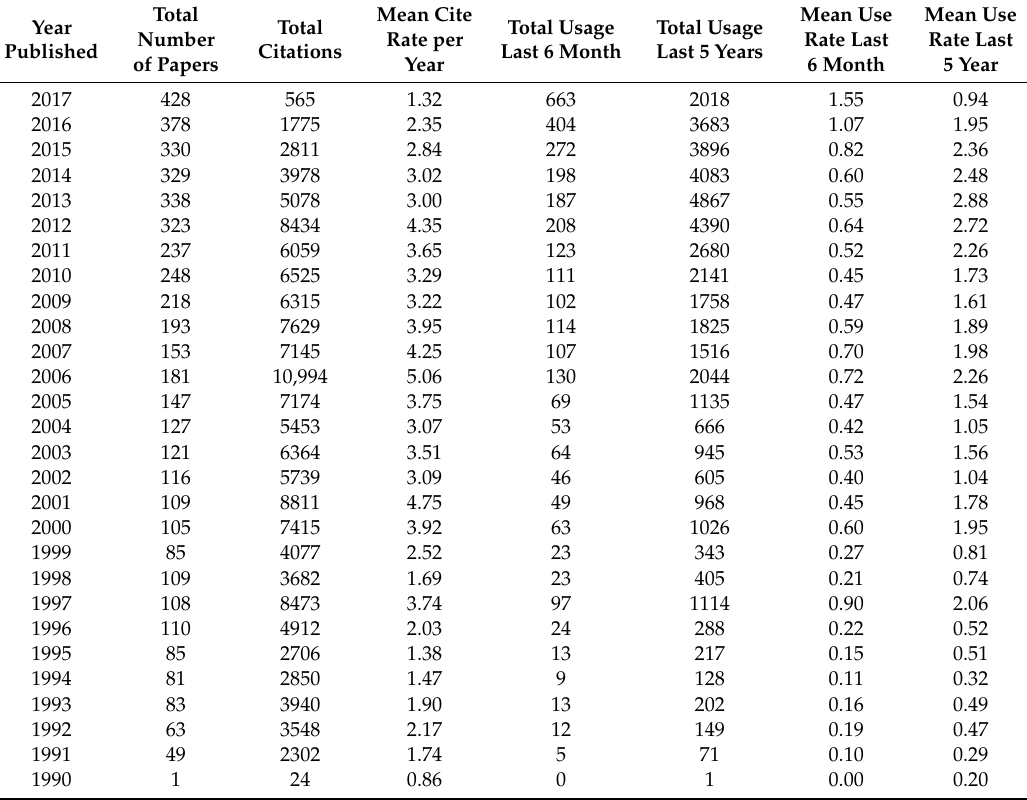
Table 1. General characteristics of publications.